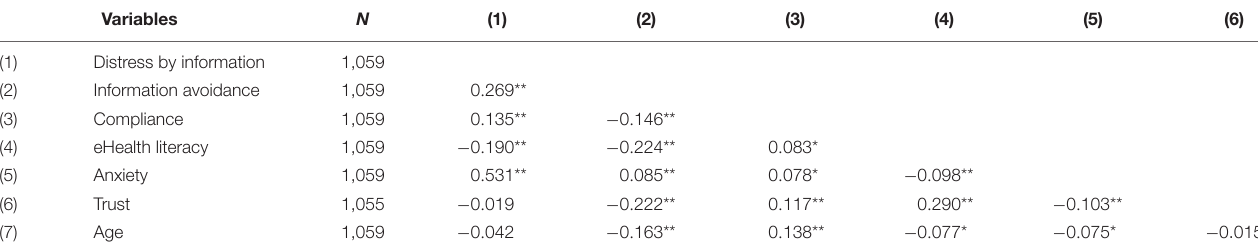
TABLE 1 | Correlation analyses of distress by information, information avoidance, compliance with preventive measures, and other variables.